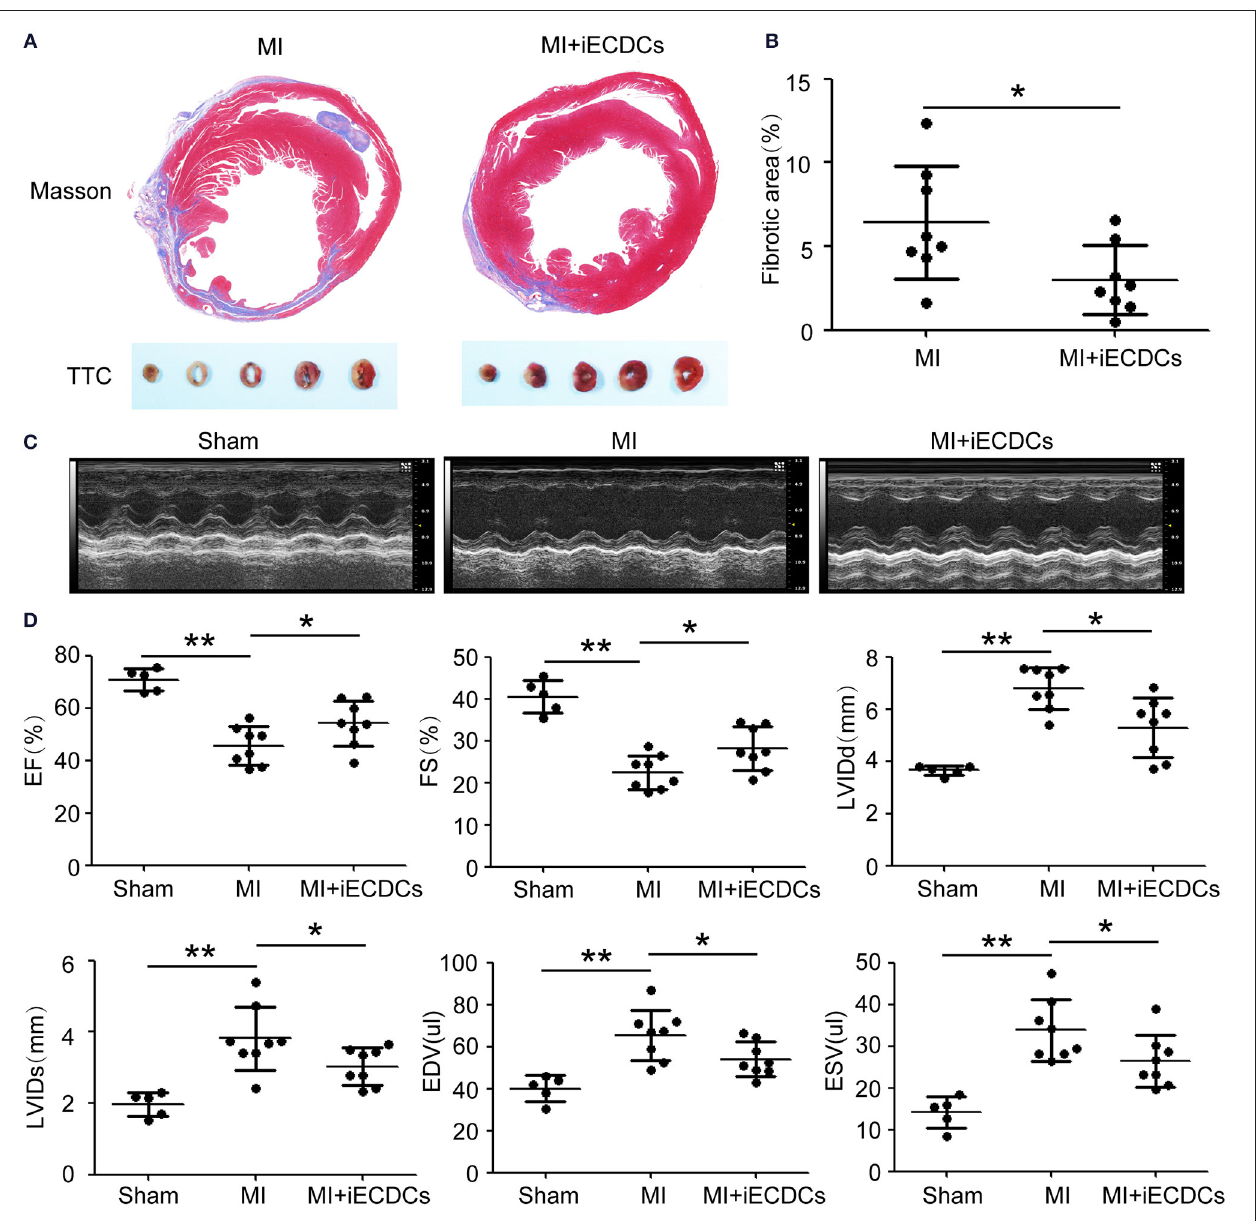
FIGURE 5 | iECDCs graft improved cardiac function in vivo . (A) Representative images of Masson’s trichrome staining and TTC staining for iECDCs-transplanted and control heart injected with same volume of phosphate-buffered saline (PBS) at 6 weeks postmyocardial infarction (MI) (scale bar = 500 µ m). (B) Quantification of the fibrotic area in iECDCs-transplanted hearts vs. PBS-treated hearts at 6 weeks post-MI ( n = 8, * p < 0.05, ** p < 0.01, one-way ANOVA post-hoc student Newman–Keuls test). (C) Representative echocardiographic images in different groups. (D) Cardiac function were evaluated by echocardiography ( n = 8, * p < 0.05, one-way ANOVA post-hoc student Newman–Keuls test). Data are presented as mean ±